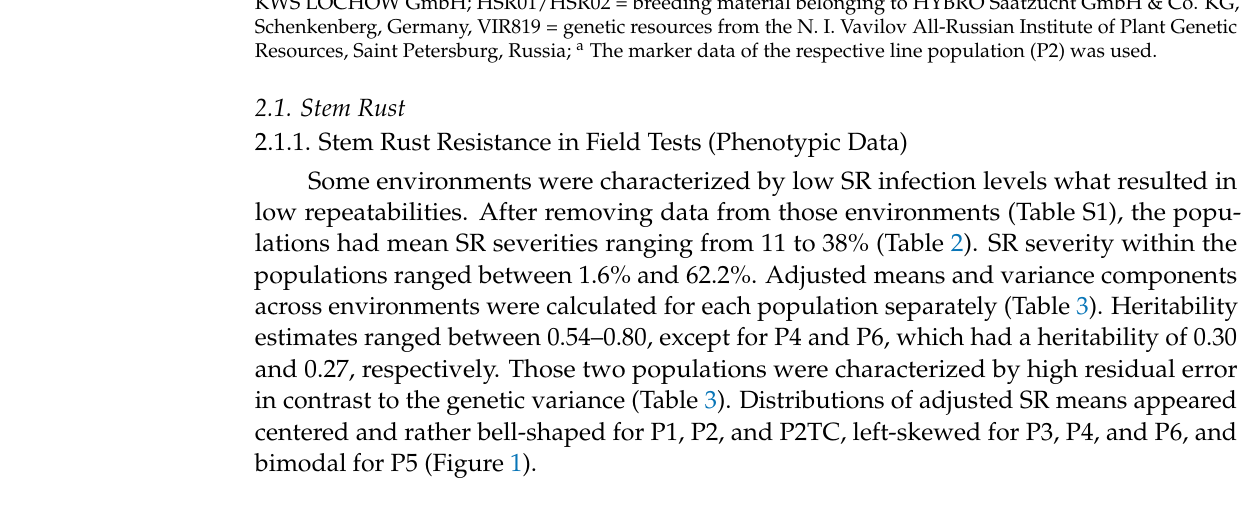
Table 2. Basic statistics for the different populations (columns) and stem rust severity.